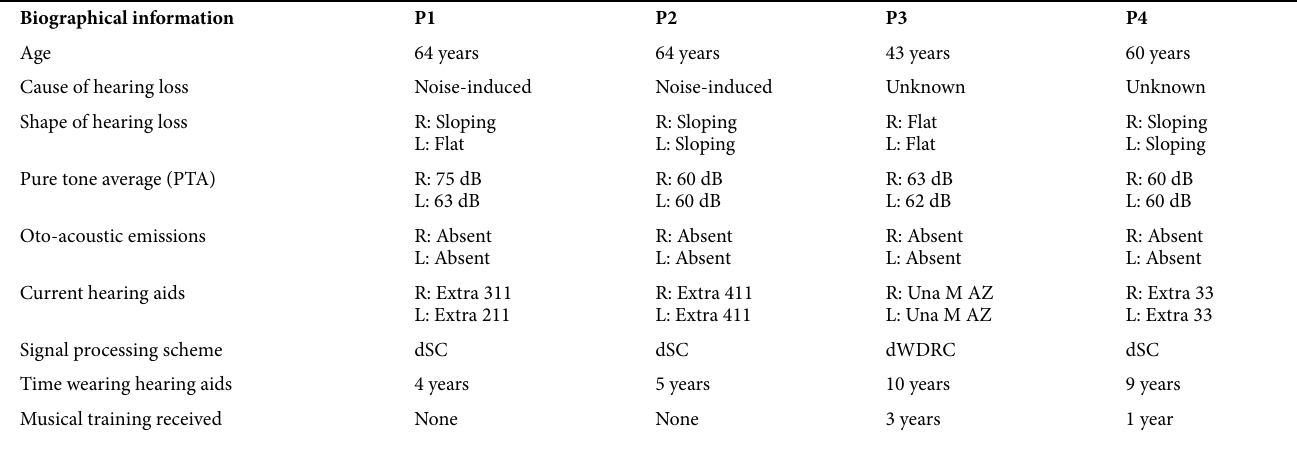
Table I. Biographical information of participants with hearing aids included in phase